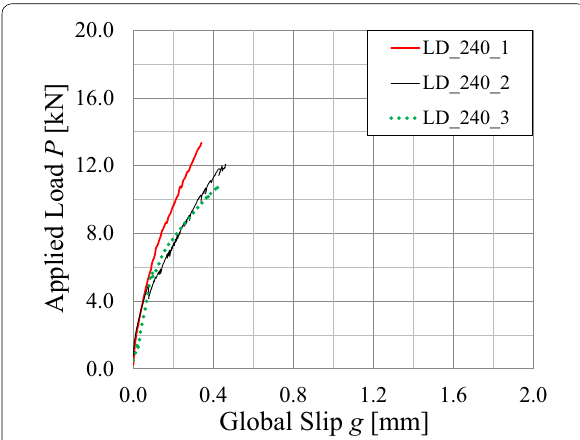
Fig. 10 Peak load-bonded length relationship of specimens with MD fibers that failed due to debonding of the composite